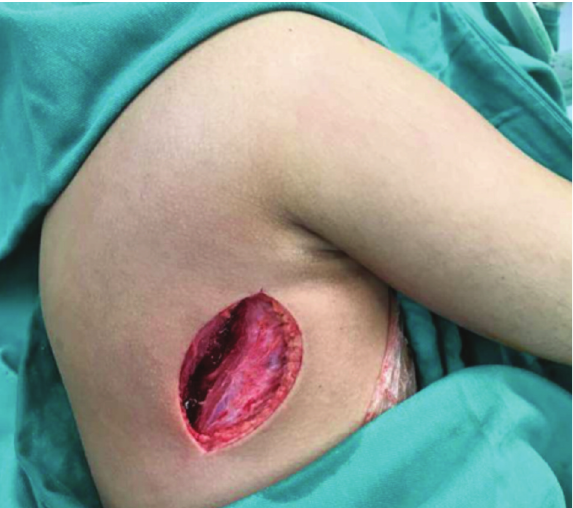
A single posterolateral surgical approach used to drain Fig. 3: scapular and axillary abscess.